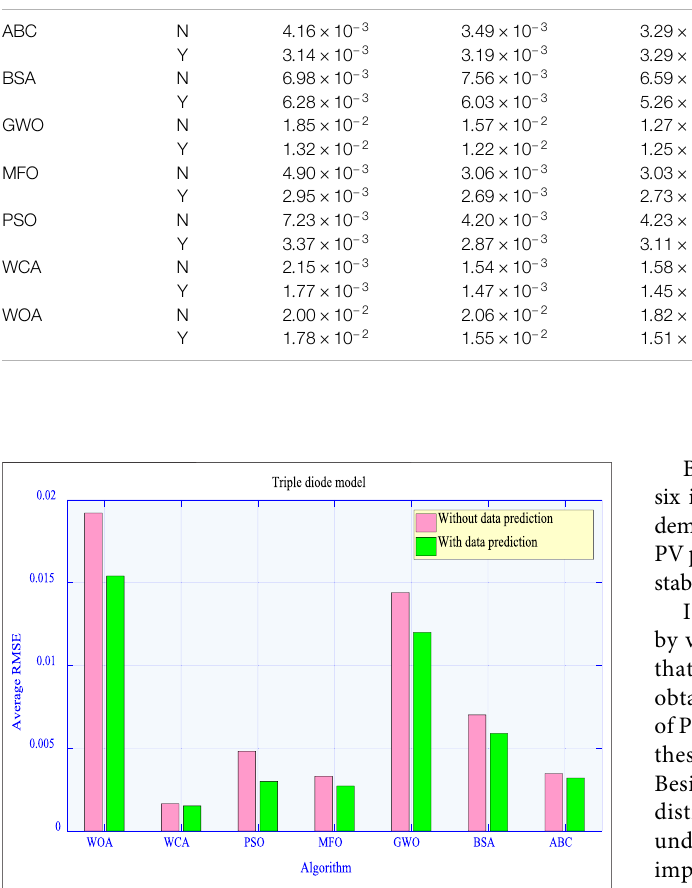
FIGURE11| ComparisonoftotalaverageRMSEvalueswithsixdifferent datasets for the TDM.